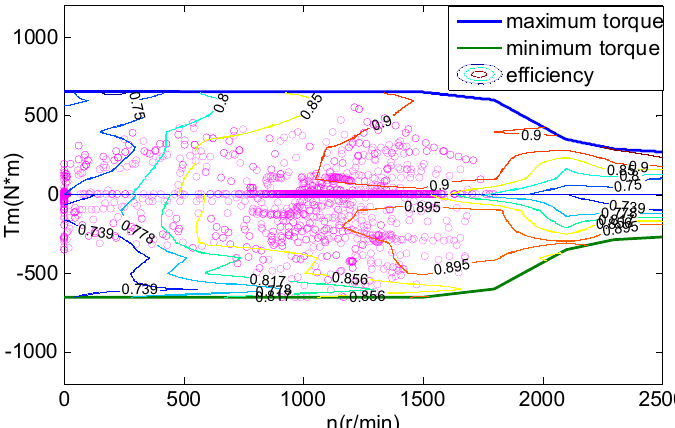
Figure 22. Distribution of the motor operating point (Rule-based).